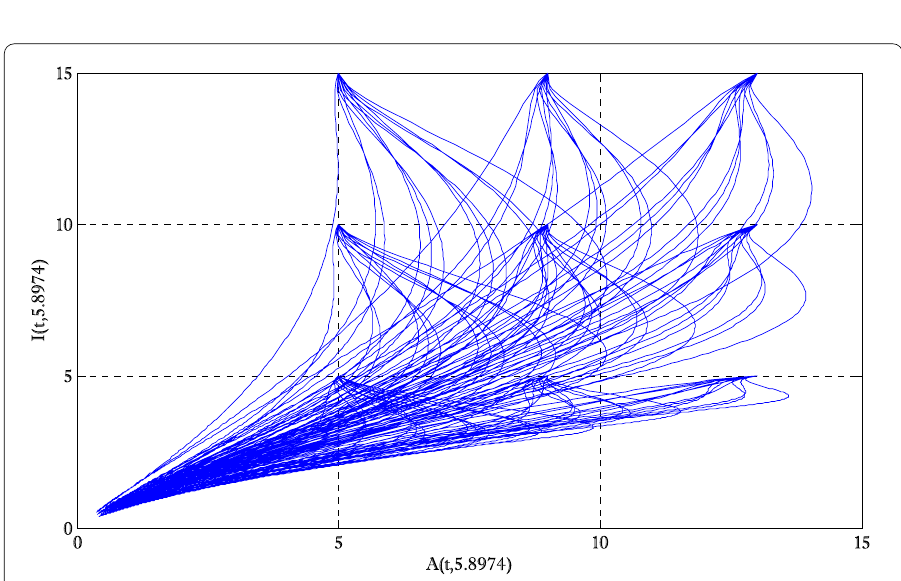
figures are given as a (cid:11) { 4,8,12,16 } , b (cid:11) { 4,7,10 } , c (cid:11) { 5,9,13 } and c 1 (cid:11) { 5,10,15 } , where a = S (0, x ), b = E (0, x ), c = A (0, x ) and c 1 = I (0, x ). The values of the parameters are given as α = 0.1, β = 0.3, γ = 0.4, σ = 0.1, μ = 0.4, d 1 = d 2 = d 3 = d 4 = d 5 = 0.9, N x = 40, N t =